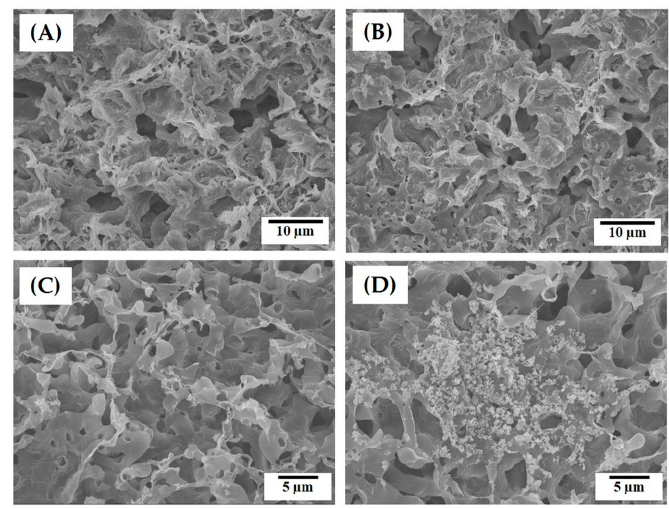
Figure 7. Representative FE-SEM images of the hierarchical macro/micro-porous porous PCL–CaP composite scaffolds produced using different CaP contents of ( A,C ) 10 wt%, and ( B,D ) 20 wt%, showing their ( A , B ) internal and ( C , D ) surface structures.